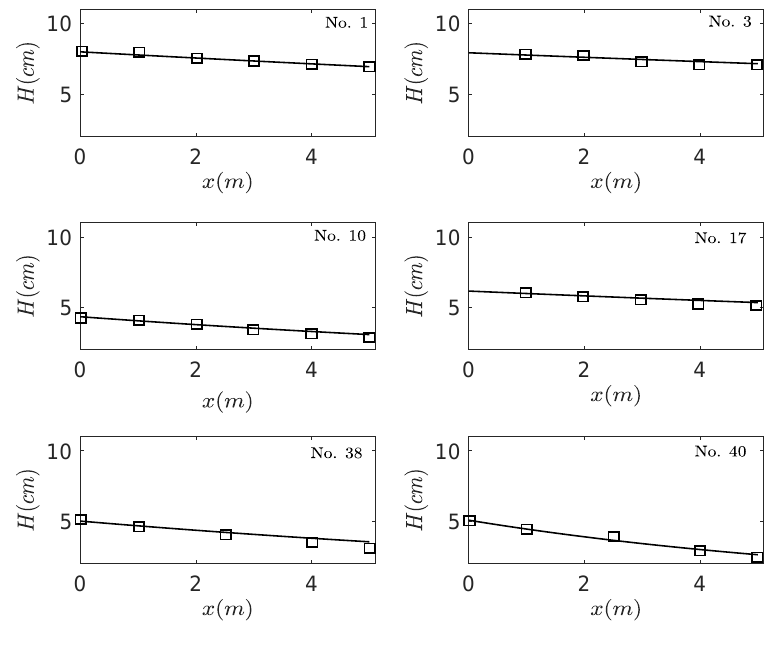
Figure 5. Comparison between the attenuated wave heights from the present model (black line) and experiments of Zhao et al. [19] (squares). The experiment number as labeled by Zhao et al. [19] is mentioned in each